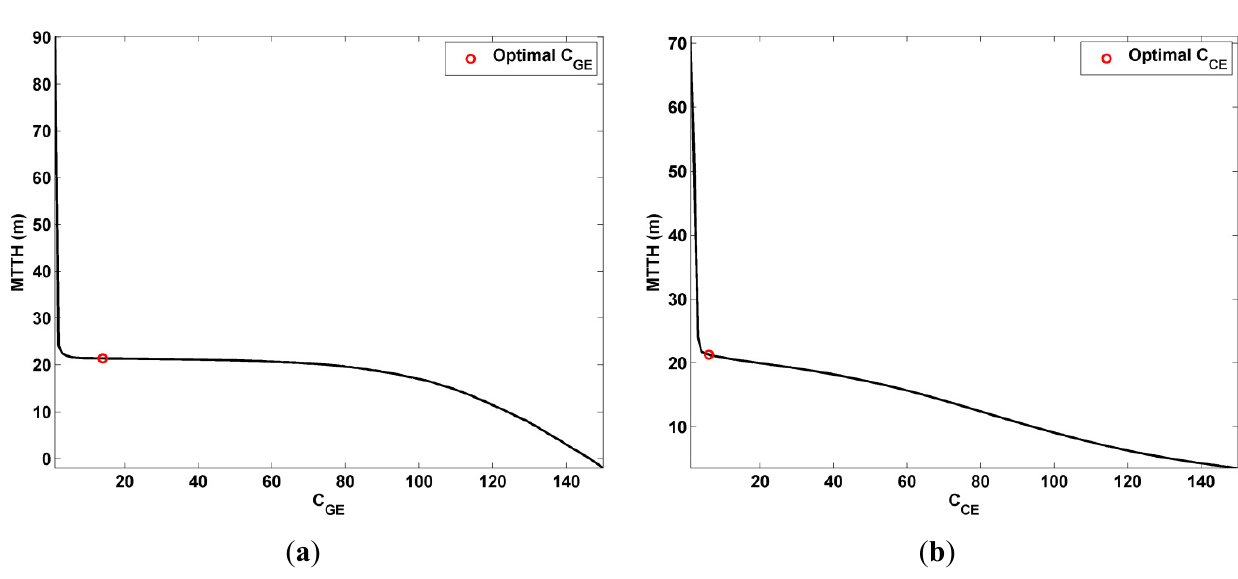
Figure 5. Mean tree top height (MTTH) against the threshold coefficients C ( b ) for the ground echo (GE) and the canopy echo (CE),